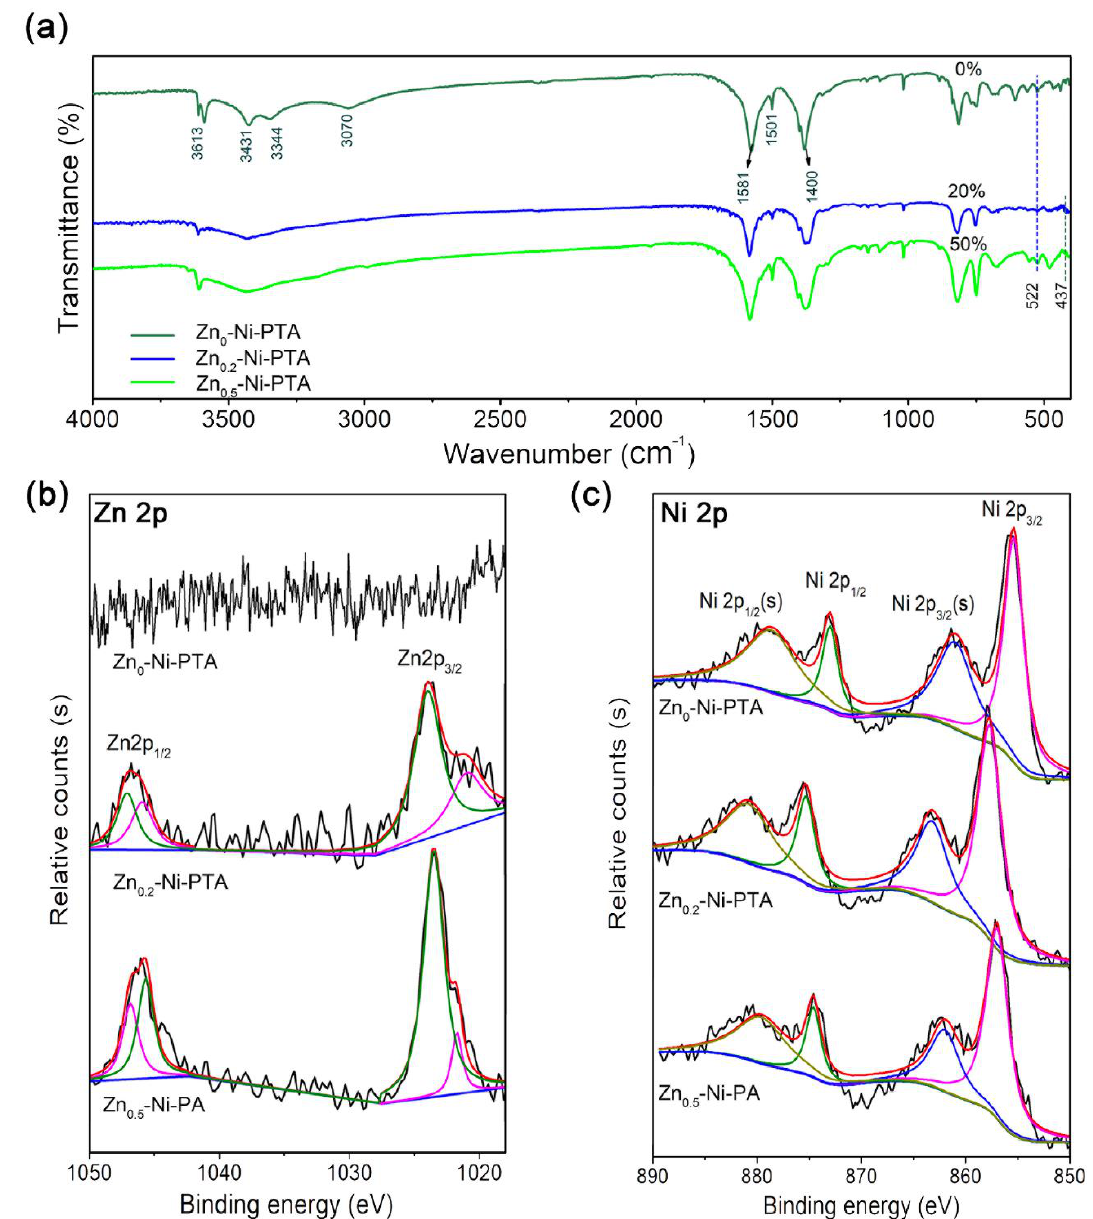
Figure 2. ( a ) FTIR pattern of the different atom fraction Zn x -Ni-PTA samples. ( b ) Zn 2p and ( c ) Ni 2p spectra of Zn x -Ni-PTA.